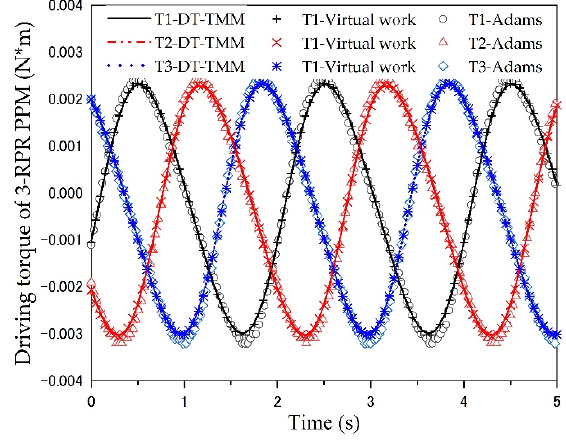
Figure 8. Driving torque of the 3-RPR PPM.